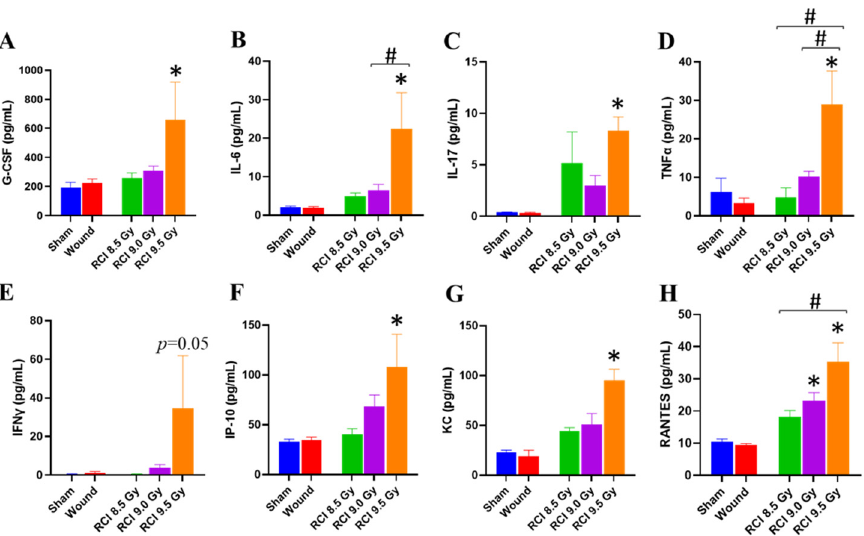
Figure 3. Increased levels of selected proinflammatory cytokines and chemokines are observed in 9.5 Gy RCI mice. ( A ) G-CSF (granulocyte-colony stimulating factor); ( B ) IL-6 (Interleukin 6); ( C ) IL-17 (Interleukin 17); ( D ) TNF- α (Tumor necrosis factor alpha); ( E ) IFN γ (Interferon-gamma); ( F ) IP-10 (interferon-gamma-induced protein 10); ( G ) KC (keratinocyte-derived cytokine); ( H ) RANTES (regulated upon activation, normal T cell expressed, and secreted). * p < 0.05 for RCI vs. sham by one-way ANOVA and Dunnett’s multiple comparisons test; # p < 0.05 for comparison among three RCI groups by one-way ANOVA and Tukey’s multiple comparisons test; N = 3–7. 3.4. RCI with Doses Ranging from 8.5 Gy to 9.5 Gy Induces Hypocellularity to a Similar Degree